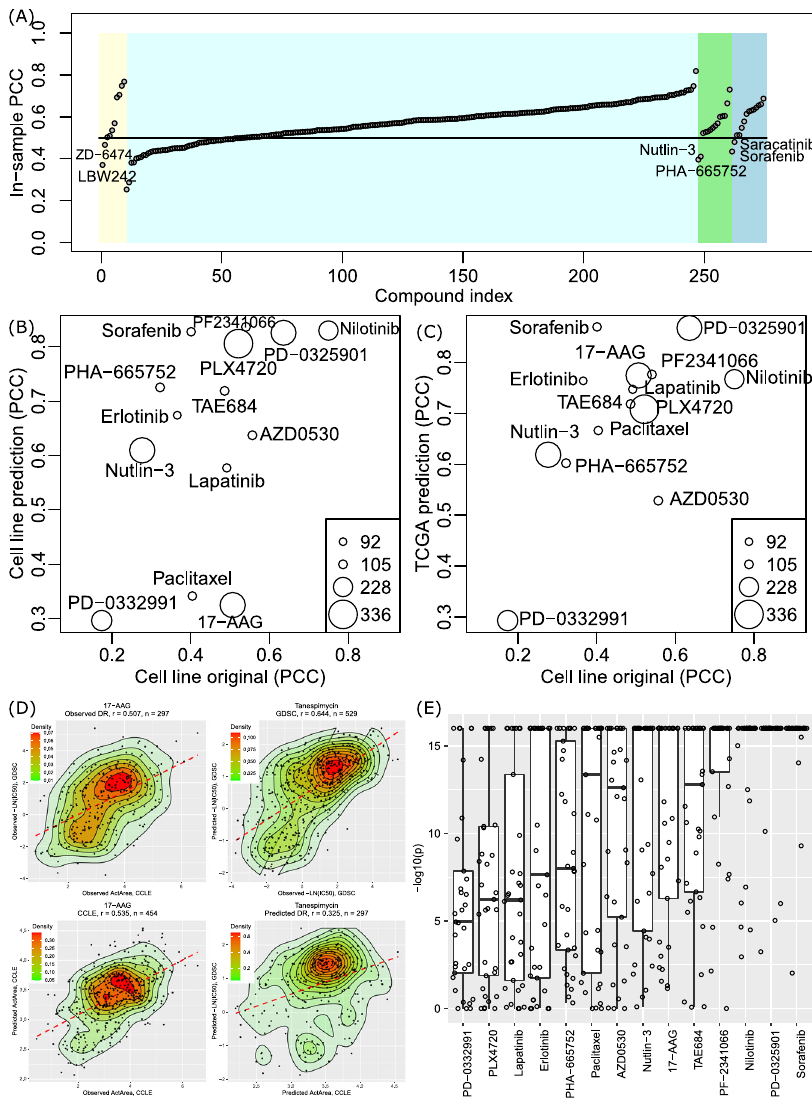
Fig. 2 Evaluation of the model ef fi ciency. A Distribution of in-sample Pearson correlation coef fi cient (PCC) for all drugs. The four panels presented the performance of drugs that are unique to CCLE ( n = 10, yellow panel), unique to GDSC ( n = 237, light-blue panel), shared drugs in CCLE ( n = 14, green panel), and shared drugs in GDSC ( n = 14, blue panel). B Evaluation of the 14 drugs shared between the CCLE and GDSC panels. x axis: PCC values of the observed drug response between CCLE and GDSC. y axis: PCC of the predicted drug response between CCLE and GDSC (using set 2, see main text). C Evaluation of the 14 shared drugs using the TCGA cancer data. x axis: PCC of the observed drug response between CCLE and GDSC. y axis: PCC of the drug response of TCGA samples ( n = 10,459) predicted using the CCLE models and the GDSC models. D Demonstration of the observed and predicted drug response using an example of a shared compound 17-AAG (also called tanespimycin in GDSC). DR drug response, r Pearson correlation coef fi cient. E Evaluation of the predicted drug response in TCGA using the CCLE models and GDSC models. For each of the 14 shared drugs ( x axis), we calculated the PCC and the P value of the predicted drug response using CCLE data and GDSC data in each of the 33 cancer types. The P value corresponds to the signi fi cance levels of correlations. y axis shows the – log10( P ) of the PCC in 33 cancer types. On x axis, compounds were ordered by the average – log10( P ) of the 33 cancer types. Each box shows the interquartile range (IQR between Q1 and Q3) for the corresponding set. The central mark (horizontal line) shows the median. The upper whisker extends from the hinge to the largest value no further than Q3 + 1.5 × IQR and the lower whisker extends from the hinge to the smallest value at most Q1 − 1.5 × IQR. For each box, all 33 values are shown as